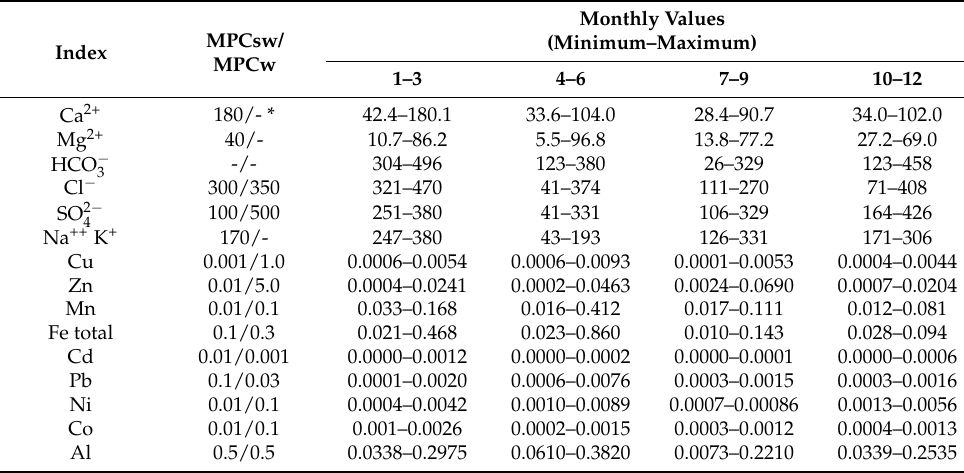
Table 7. Seasonal dynamics of the content of main ions, microelements and heavy metals in the water of the Ishim River 2013–2019